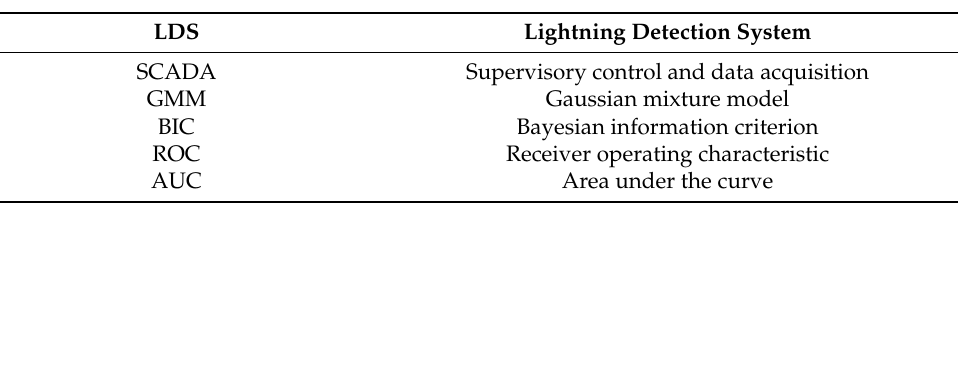
Table 1. List of symbols, acronyms and